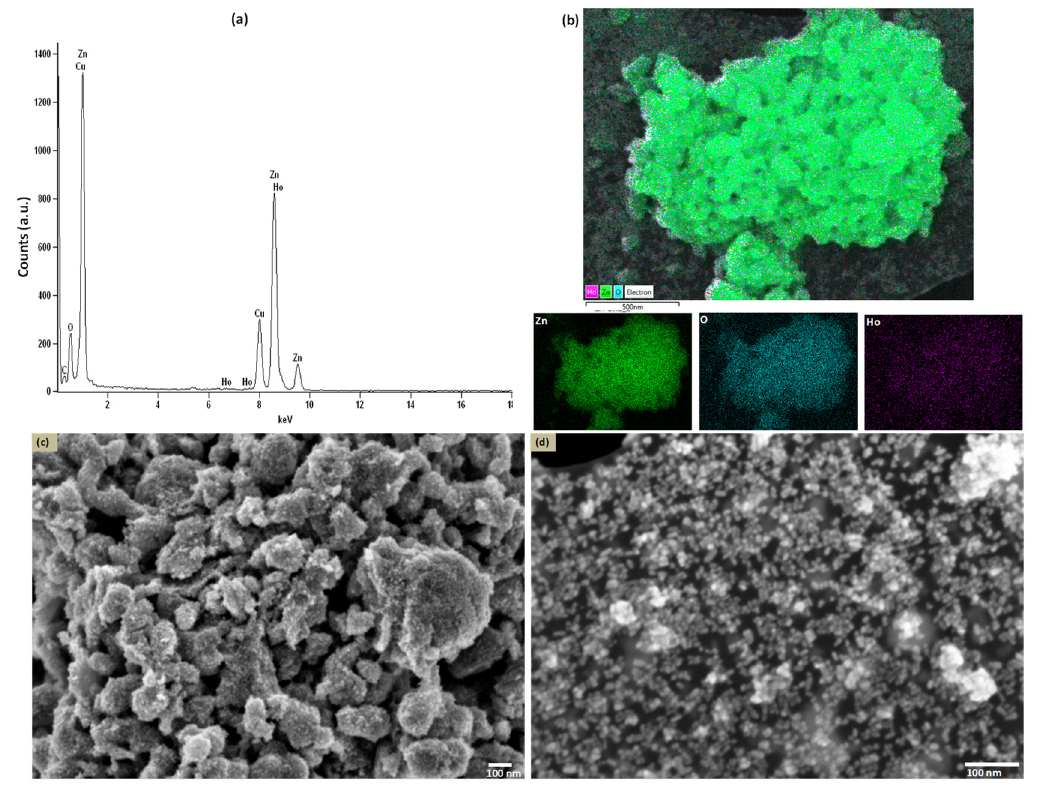
Figure 1. EDS ( a ) spectrum and ( b ) elemental mapping for 0.5 mol% Ho 3+ -doped ZnO nanocrystals. SEM micrographs for ( c ) un-doped ZnO and ( d ) (0.5 mol%) Ho 3+ -doped ZnO nanocrystals.